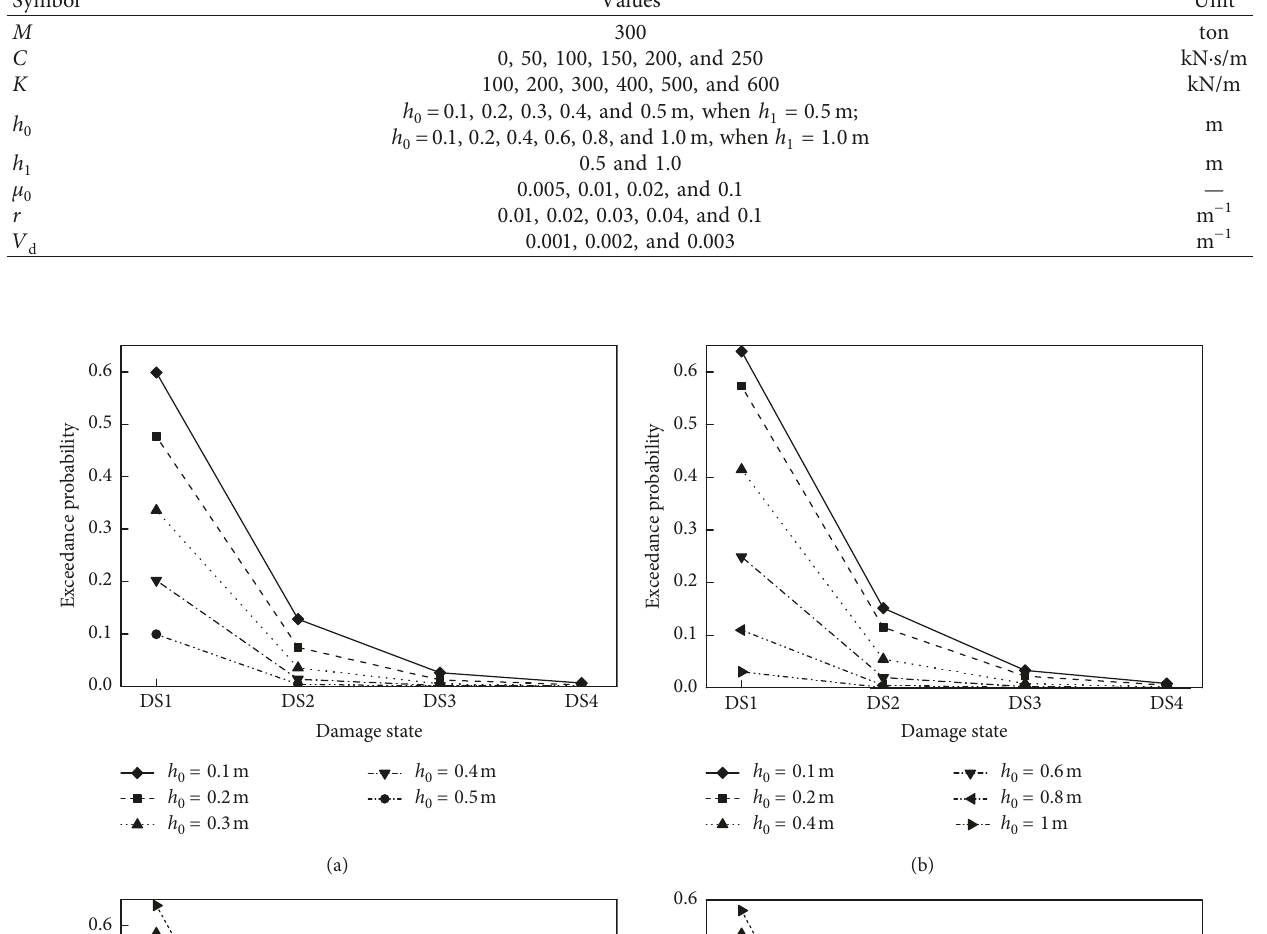
100kN/m, C (cid:31)